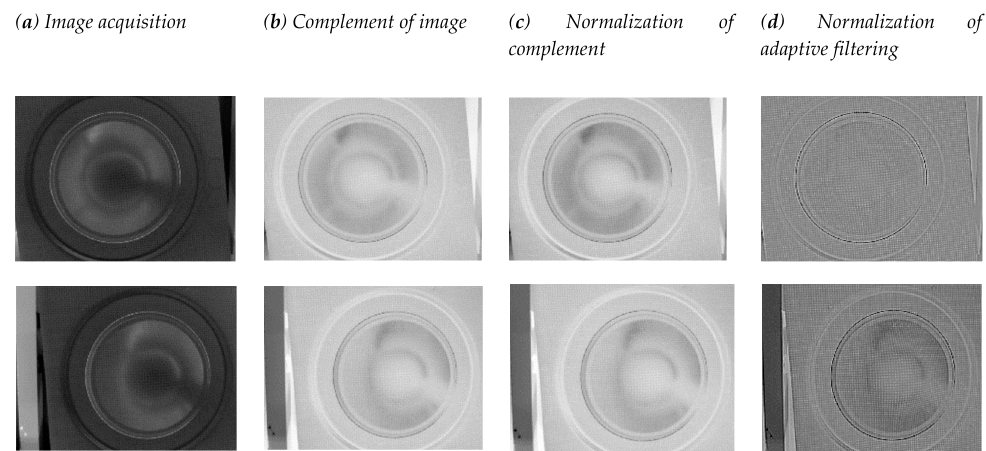
Figure A1. Pair of images of the stereoscopic system showing the result of each stage of the pre-processing of images. The upper row presents the left-side images, and the lower row presents those from the right-side.